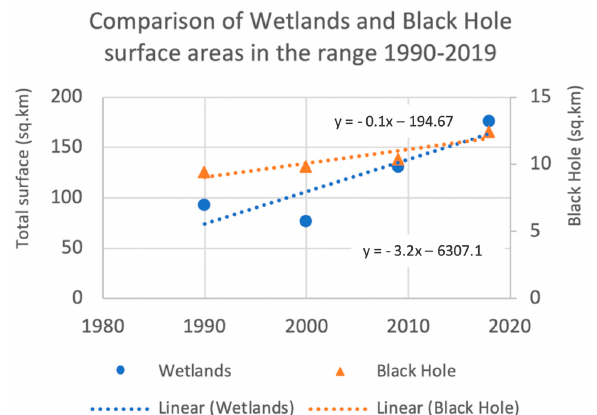
Figure 11. Trends of the changes of total surfaces of wetlands and of Black Hole over time.